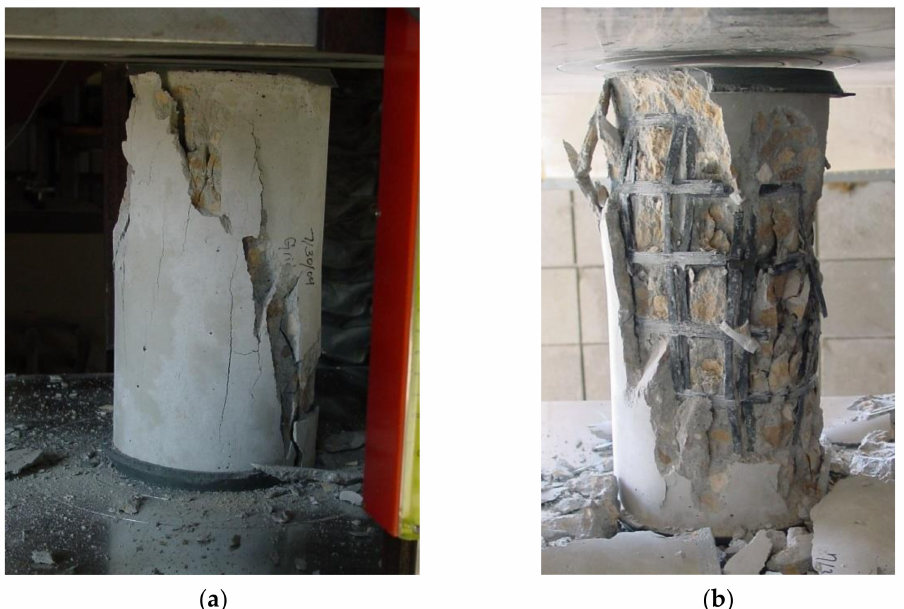
Figure 6. Cylindrical specimens after testing: ( a ) typical failure for control specimens, and ( b ) typical failure of grid specimens caused by rupture of CFRP grid strands [3].